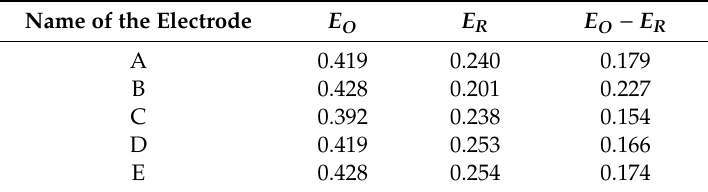
Table 2. Oxidation potential ( E O ), reduction potential ( E R ) and the difference between E O and E R of different NiO electrodes.